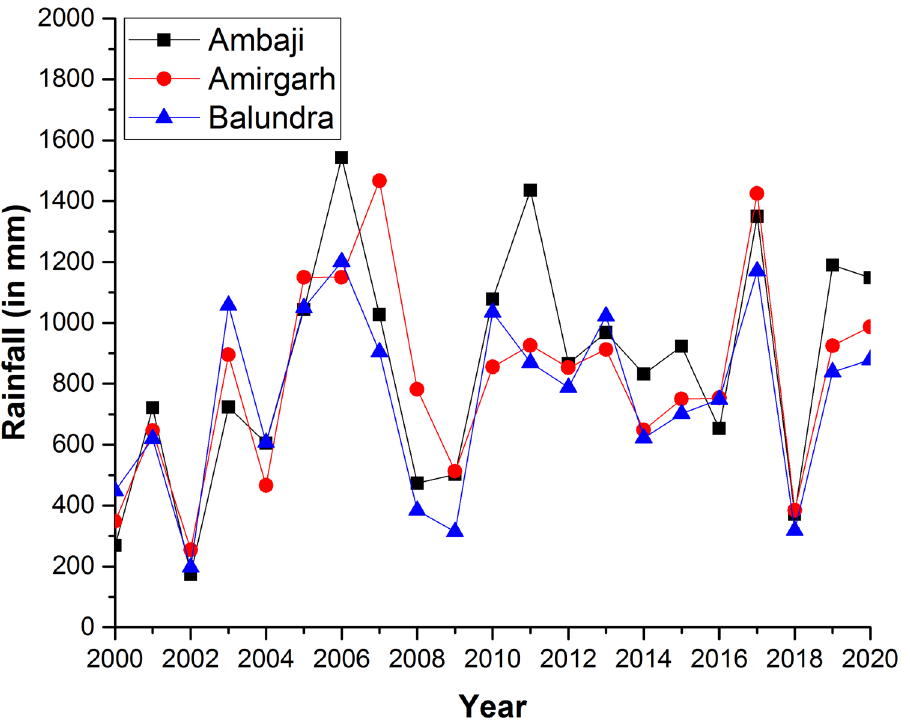
Figure 17. Decadal precipitations (2000–2020) data in the study area compiled from Water Resources Department, Govt. of Gujarat. (Source: https:// swhyd rology. gujar at. gov. in/).